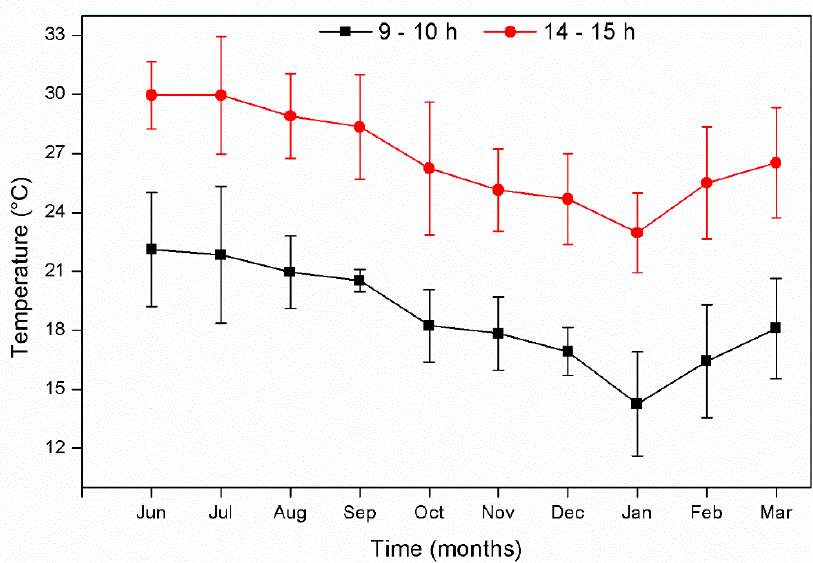
Figure 2. Environmental temperatures registered at 9–10 h and 14–15 h during the experimental period. Values are given as the mean ± standard error.